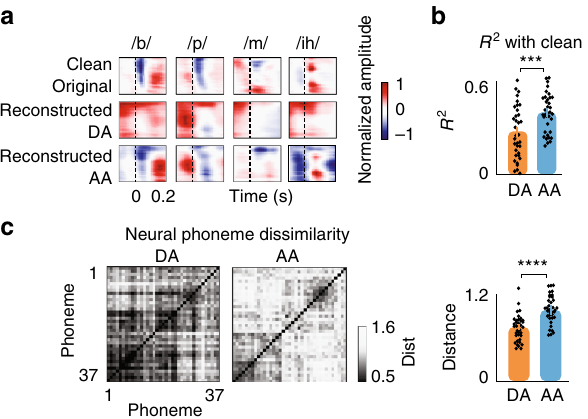
Fig. 3 Neural degradation of phonetic features during adaptation. a Comparison of average phoneme spectrograms calculated from original clean spectrograms (top row), reconstructed from neural responses during adaptation (DA, middle row) and reconstructed from neural responses after adaptation (AA, bottom row). b Correlation between phonemes using reconstructed spectrograms and original clean spectrograms for the two intervals of during adaptation and after adaptation (mean±s.e.m. across phonemes, N = 37, *** paired t -test, p < 0.01). c Left: Phoneme dissimilarity matrices using pairwise correlation distances between phonemes for the two intervals of during adaptation and after adaptation. Right: Comparison of the average distance between phonemes during adaptation and after adaptation (mean±s.e.m. across phonemes, N = 37, **** paired t -test, p